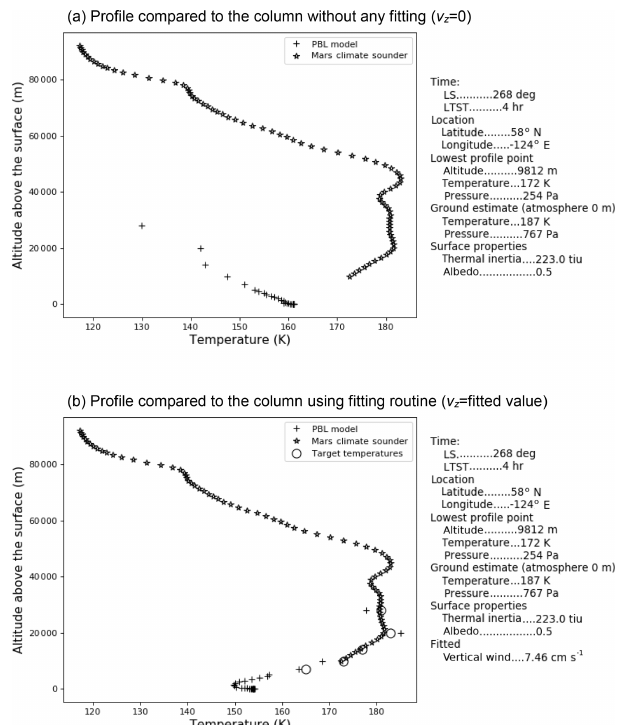
Figure B2. Fitting of the model to the MCS temperature profile using target temperatures. Panel (a) shows the results of a column model, without the adiabatic heating term, initialised based on MCS data for the particular profile shown. Panel (b) shows the results af- ter the fitting algorithm is run. The open circles are the target tem- peratures for the fitting algorithm. The figure is a result of entering a “2” into the analysis field of the GUI shown in Fig. 3. Vertical wind and v z are the maximum vertical wind speed from Eqs. (2) and (3) in Sect.